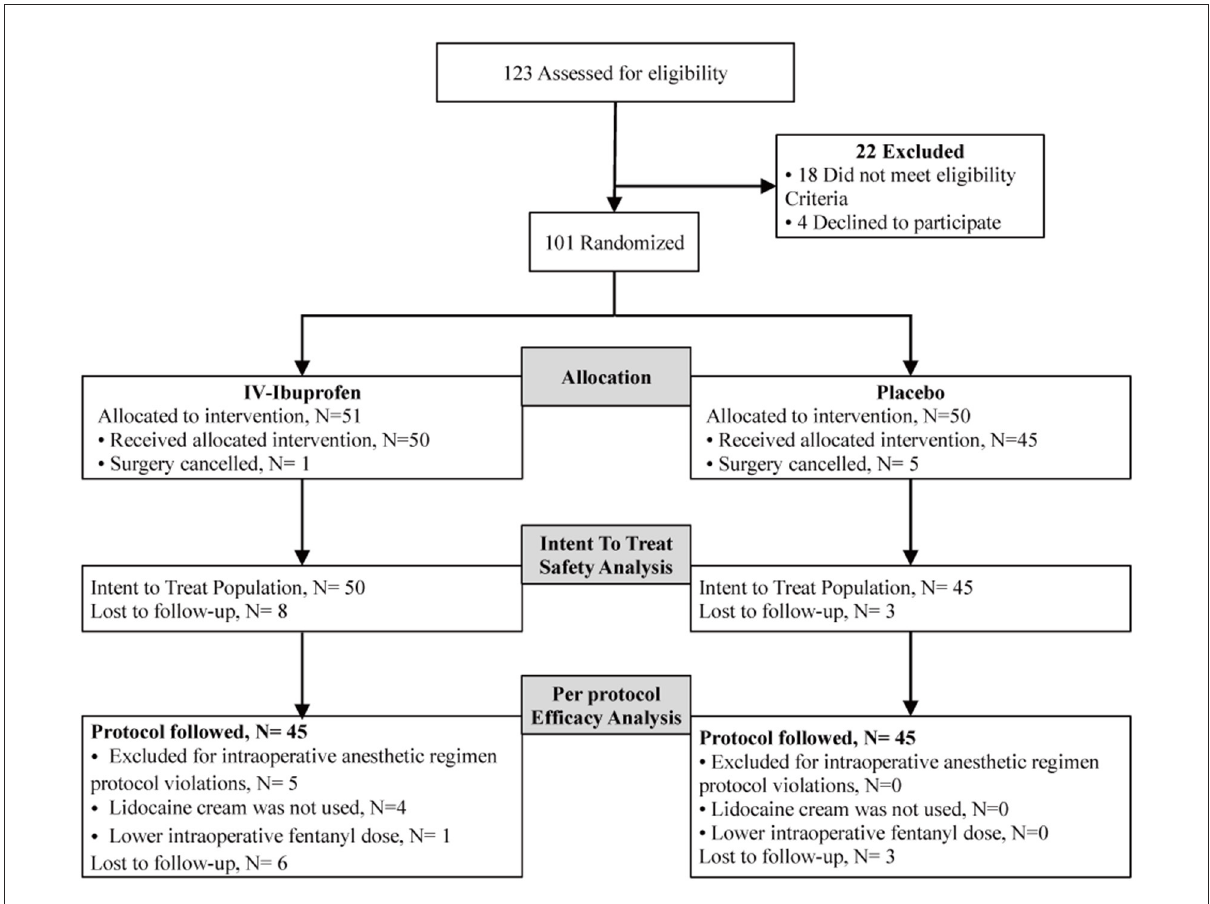
FIGURE1 Participant